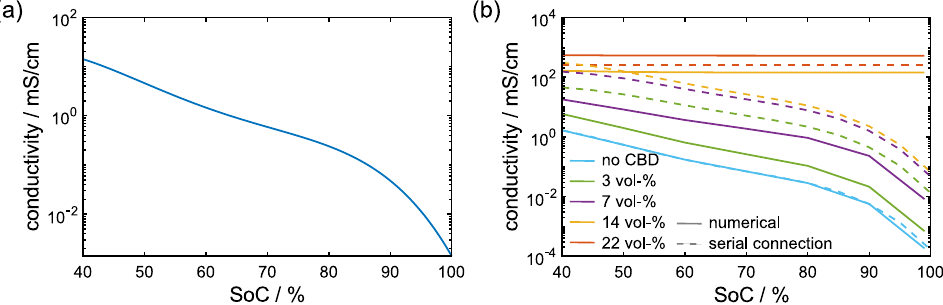
Figure 3. ( a ) Dependence of the electronic conductivity of NMC on the SoC [2]; ( b ) effective electronic conductivity of an electrode with 50 vol-% CAM content, d 50 = 14 µm particle diameter and varying CBD content. Solid lines represent numerical conductivity simulations ( κ ef f , num s ) and dashed lines are a result of the conductivity model based on the geodesic tortuosity computations ( κ ef f , geo s , Equations (20) and